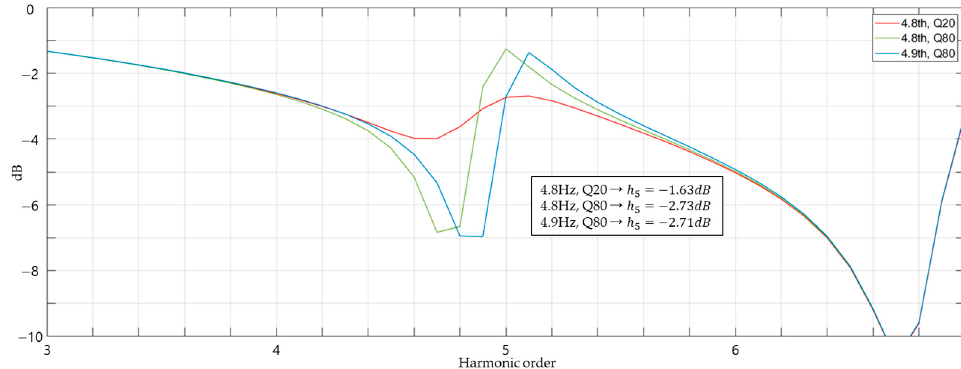
Figure 11. Attenuation with 5th HF parameters changed.